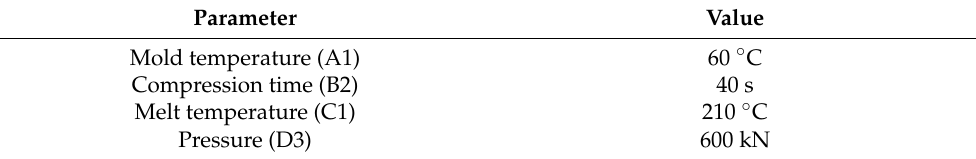
Figure 2. S/N ratio response graph. Table 8. Average responses of S/N ratio and delta.